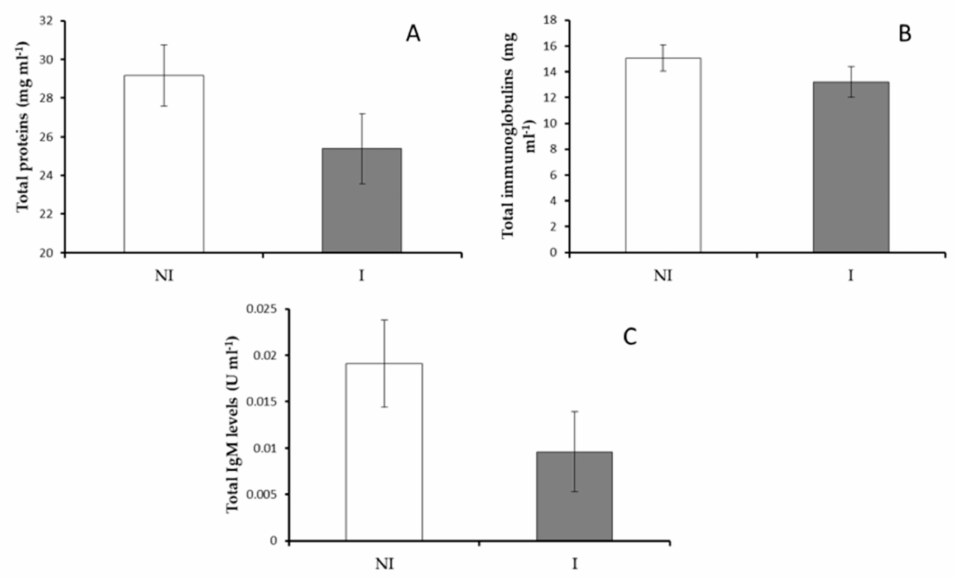
Figure 4. Serum immune response in non-infected (NI) and infected (I) European sea bass. ( A ) Total protein levels, ( B ) total immunoglobulin levels and ( C ) total IgM levels. Data are represented as means ± SEM (n = 9).